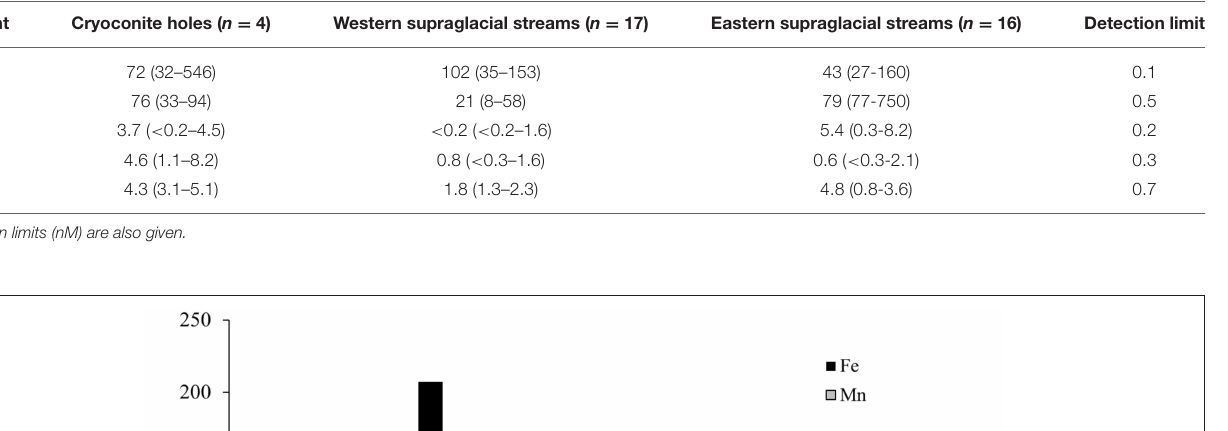
Frontiers in Earth Science |